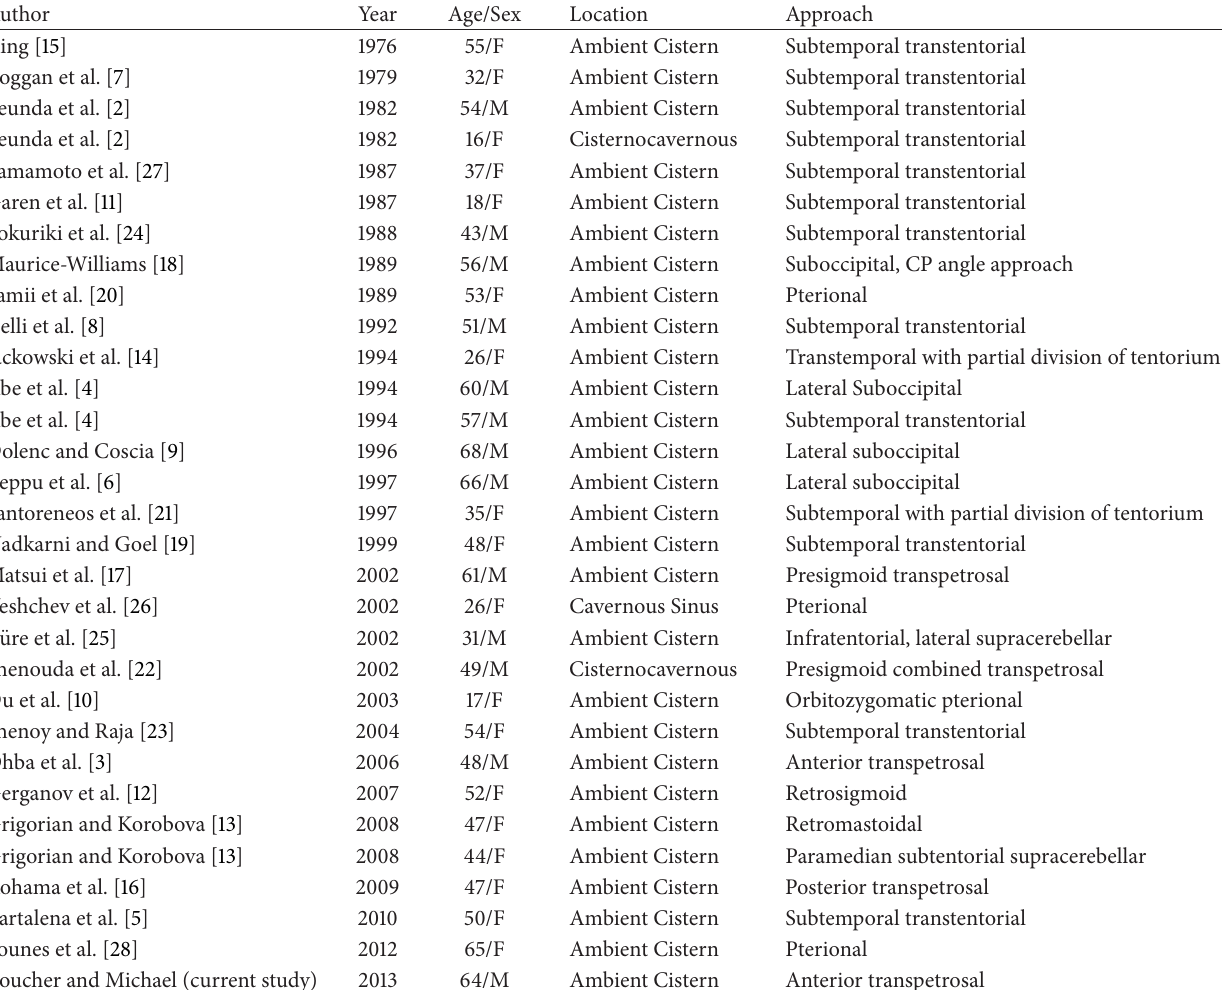
Table 1: Prior Surgically-Defined Trochlear